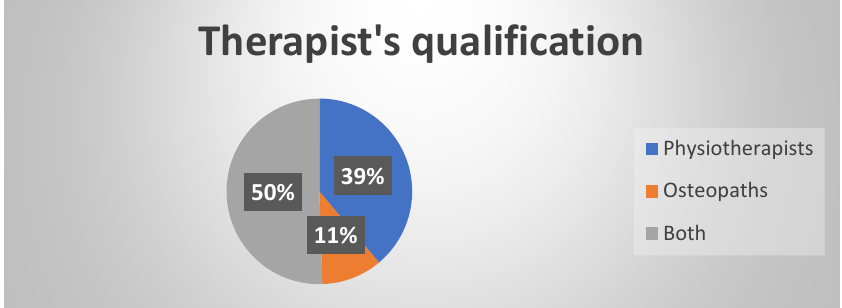
Figure 1. Therapist’s qualification.